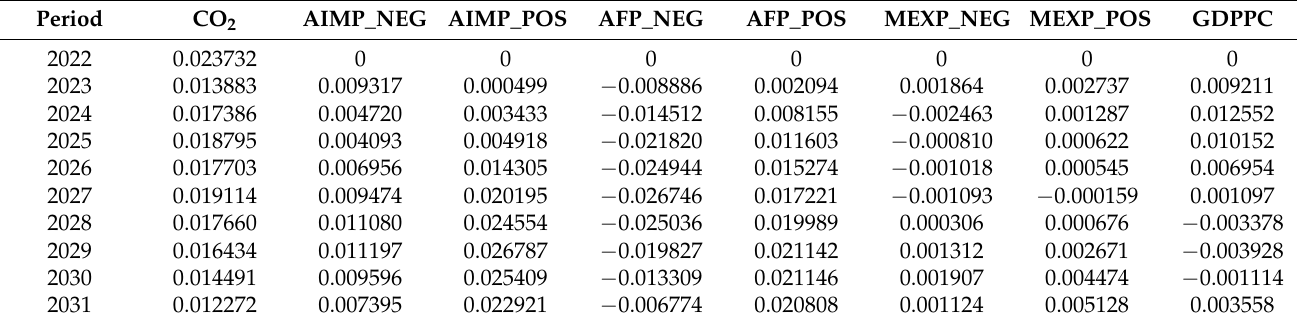
Table 8. Asymmetric IRF estimates of CO 2 emissions.